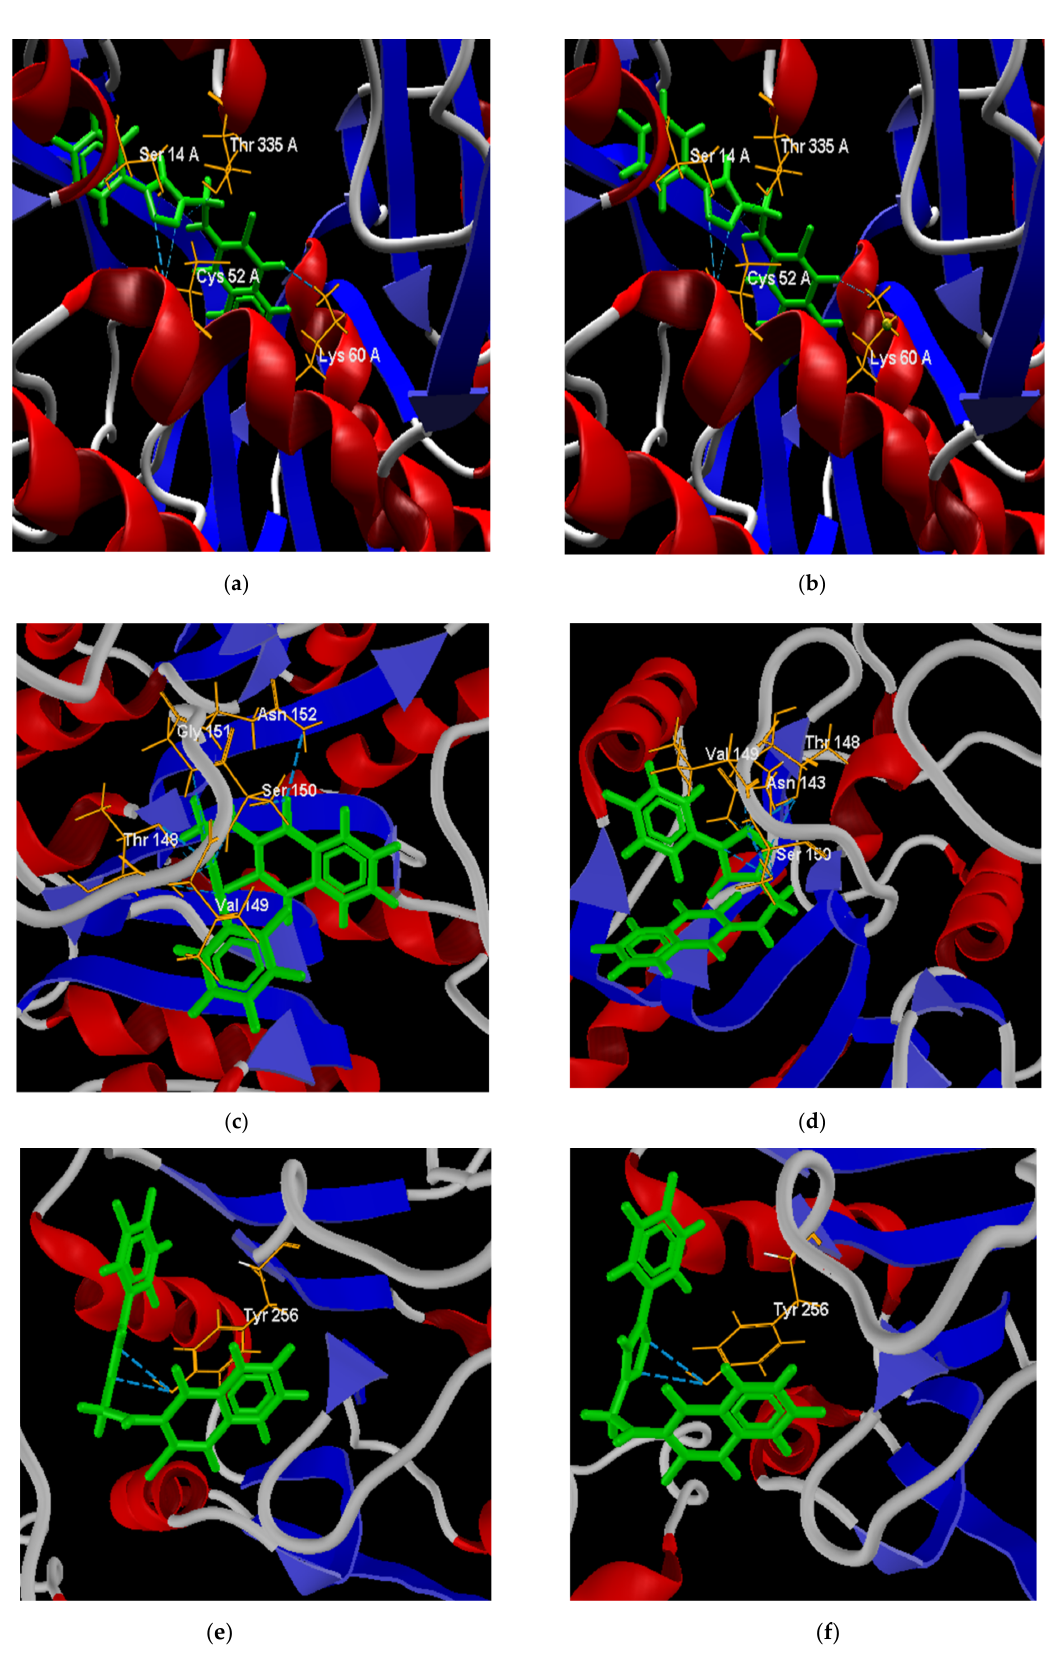
Figure 9. Best poses of derivatives: 64 ( a ) and 65 ( b ) in the active site of the L Tr protein; 64 ( c ) and 66 ( d ) in the active site of the La A protein; and 64 ( e ) and 67 ( f ) in the active site of the Li At protein. The best positions of structures 64 and 66 in the active site of the La A protein (Figure 9c,d) presented both interactions by hydrogen bonds with residues Ser 150, Thr 148, and Val 149. Structure 64 presented hydrogen bonds with residues Gly151 and Asn 152, while structure 66 formed an interaction with residue Asn 143. In similar studies [94,95], some flavonoid ligands showed interactions with amino acid residues Ser150, Asn 152, and Asn153 within the active site, exhibited high in vitro activity against L. amazonensis cul- tures, and low toxicity in mammalian cells. Residues Ser150 and Asn143 are involved in the Mn(II) metal bridge in coordination with the active site of arginase, which is required to conduct its catalytic activity [95,96]. According to this, molecules 64 and 66 inhibit the coupling of the metallic bridge, and would be good inhibitors of the arginase protein. The poses of structures 64 and 67 facing the Li At receptor are presented in Figure 9e,f. Both structures present interaction by hydrogen bonds with the residue Tyr 256. It has been shown that this residue prevents the rotation of the pyridine ring of the pyridoxal phosphate cofactor until the entrance of the amino acid, avoiding its stability [97]. 2.3. ADME Analysis Theoretical early estimation of ADME properties for the series of 68 1,4-naphthoqui- none derivatives was performed in the free SwissADME web tool [98]. The data of lipo- philicity, solubility, pharmacokinetic properties, and skin permeability parameters are collected in Table S21. Figure 10 shows the estimated lipophilicity values of the 68 ligands, expressed as the logarithm of the octanol–water partition coefficient (Log P o/w ). This parameter makes it possible to determine hydrophobicity, which is a parameter considered in the initial phases of drug development, and which allows inferring how the compound will behave in biological fluids and its possible diffusion through biological membranes [77,99]. The lipophilic results show that the 68 derivatives have a Log p < 5 [100], so according to the Lipinski Rules, they can be administered orally [101]. NQ–Amine derivative 43 presented the lowest value (log P o/w = 0.49), that is, it is more hydrophilic than the rest.